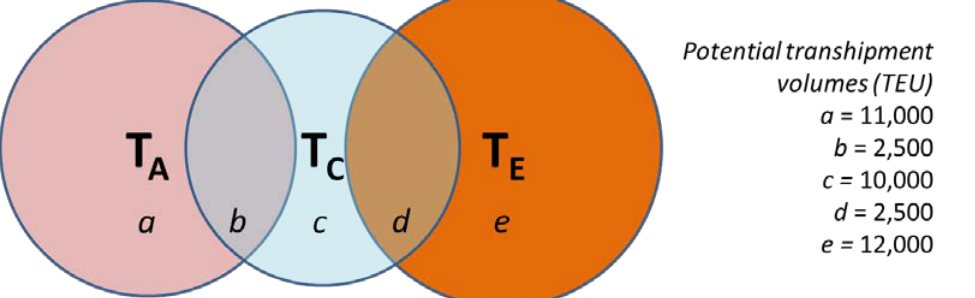
Figure 5. Overlapping market areas and the potential transhipment volumes of T A = a + b, T C = b + c + d and T E = d + e. (Note: the size of the market area does not correspond to the potential transhipment